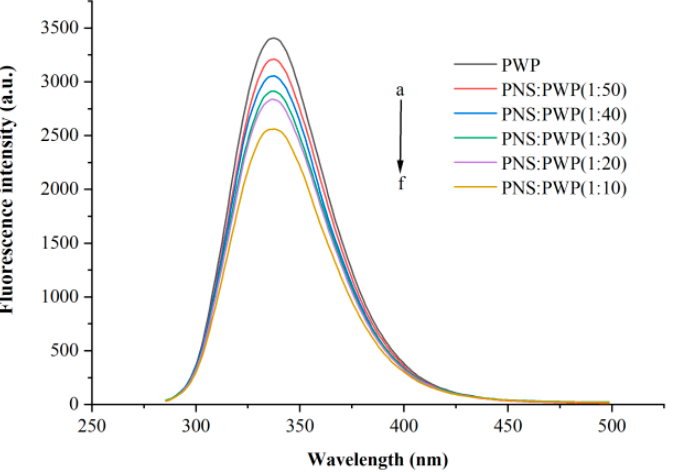
Figure 3. Intrinsic fluorescence spectra of PWP in the presence of different PNS mass. a–f: PWP,